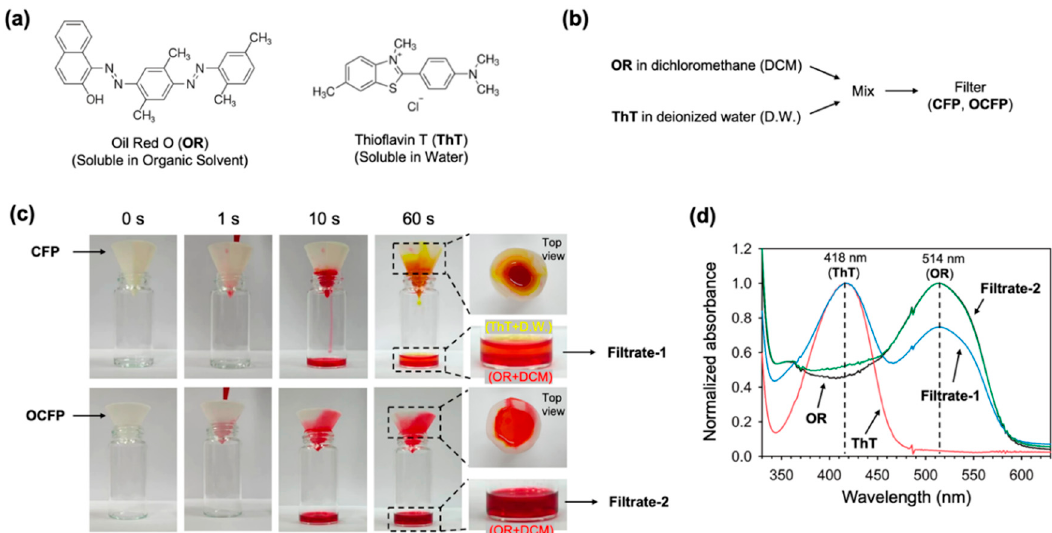
Figure 3. Separation of the oil-water mixture. ( a ) Chemical structures of oil-soluble Oil red O (OR) and water-soluble Thioflavin T (ThT). ( b ) Scheme of the oil-water separation analysis. DCM (with 0.01% Oil red O) and D.W. (with 0.01% Thioflavin T) were mixed using a vortex mixer. ( c ) Separation of the oil-water mixture using CFP and OCFP. ( d ) Normalized UV–Vis spectra of Oil red O (OR, black trace), Thioflavin T (ThT, red trace), filtrate 1 (after filtration of oil-water mixture through CFP, blue trace), and filtrate 2 (after filtration of oil-water mixture through OCFP, green trace).